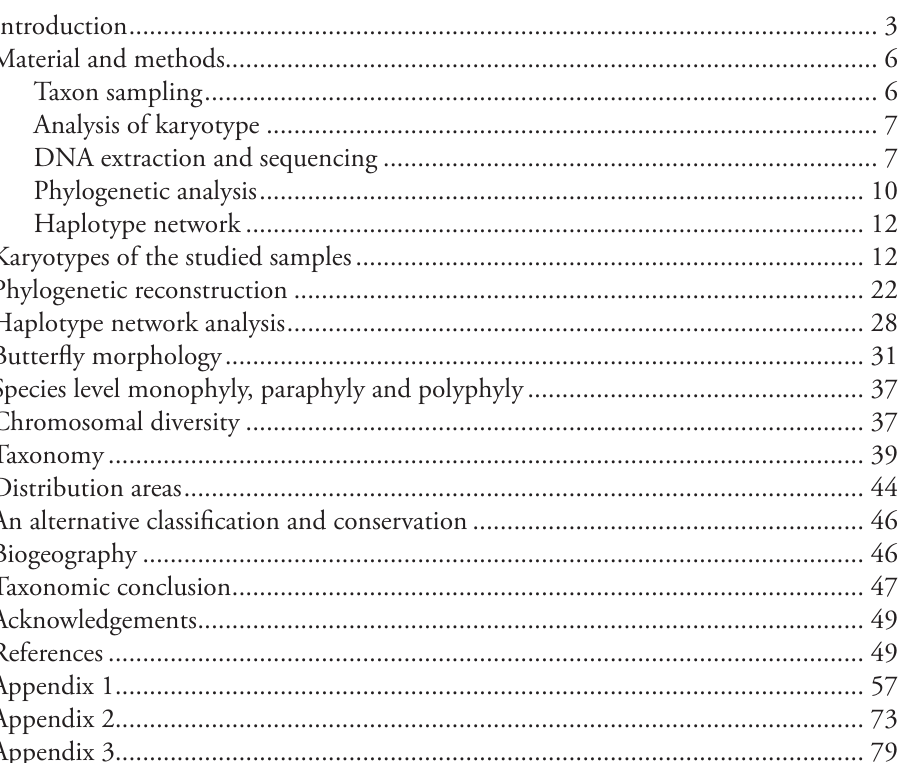
Maria S. Vishnevskaya et al. / Comparative Cytogenetics 10(5): 1–85 (2016) 2 tains) we describe Polyommatus timfristos Lukhtanov, Vishnevskaya & Shapoval, sp. n. which differs by its haploid chromosome number (n=38) from the closely related and morphologically similar P. aroaniensis (n=47-48) and P. orphicus (n=41-42). We provide chromosomal evidence for three separate south Balkan Pleistocene refugia (Peloponnesse, Central Greece and Northern Greece/South Bulgaria) and stress the biogeographic importance of Central Greece as a place of diversification. Then we argue that the data obtained have direct implications for butterfly karyology, taxonomy, biogeography and